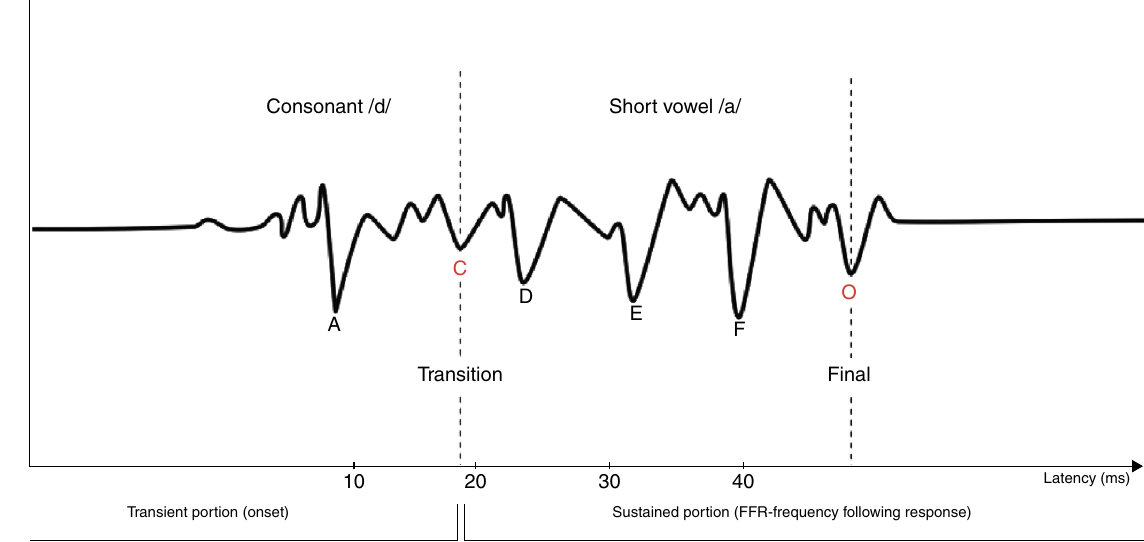
Representation of electrophysiological response to synthesized syllable /da/. Personal file of the investigator of an assessment performed with BioMARK TM software.